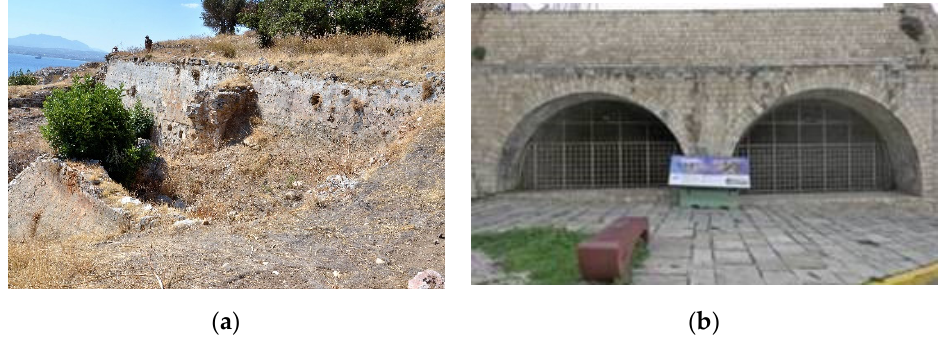
Figure 7. Venetian hydro-structures: ( a ) cistern (of rectangular cross section) in the Palaiokastron in eastern Iraklion used mainly for water supply and ( b ) central cistern of two linked chambers in the Arsenal Nuovi (close to the Venetian port) in Iraklion city (photos by A. N. Angelakis).